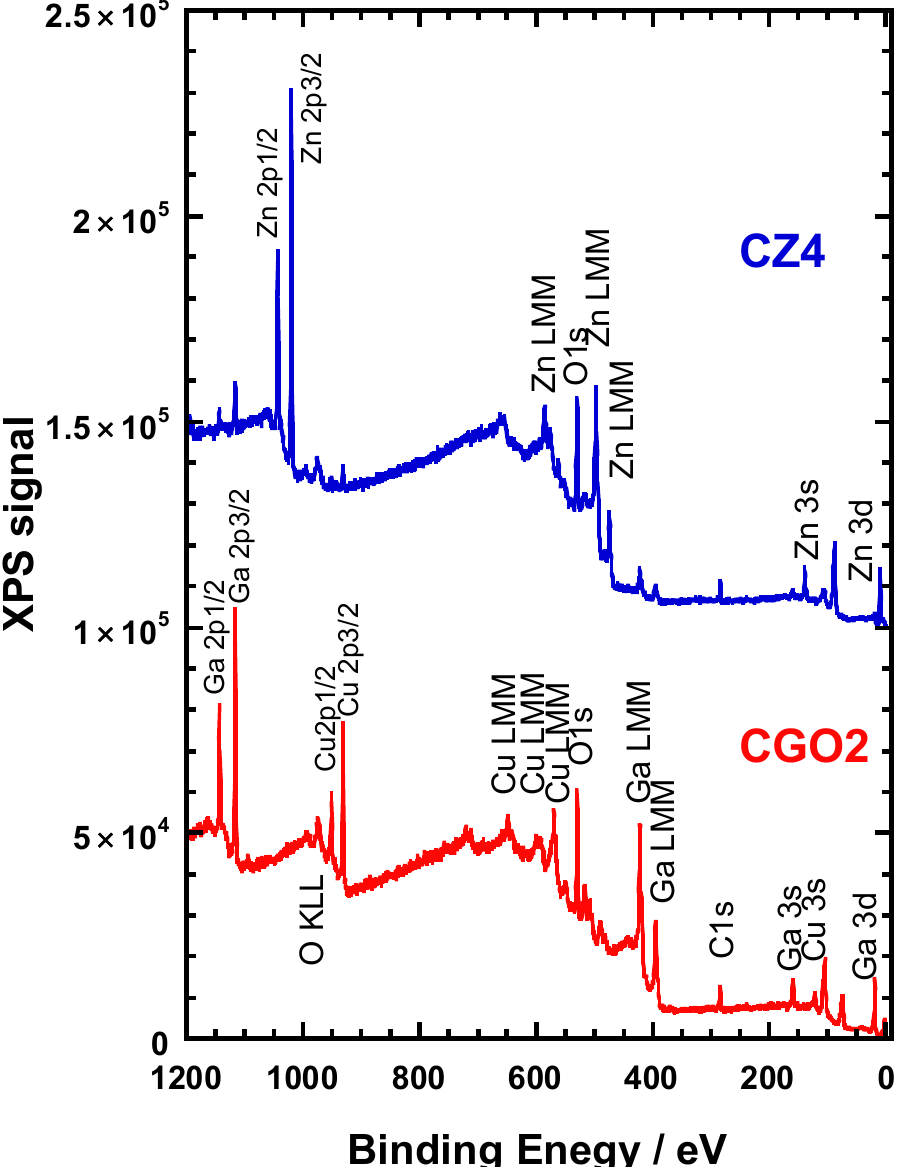
Figure 7. The survey scan spectra of the CGO2 base crystal and CZ4 hybrid. Table 2. Peak position and width (±0.1 eV) of each of the XPS CL peaks for CGO2 and CZ4.